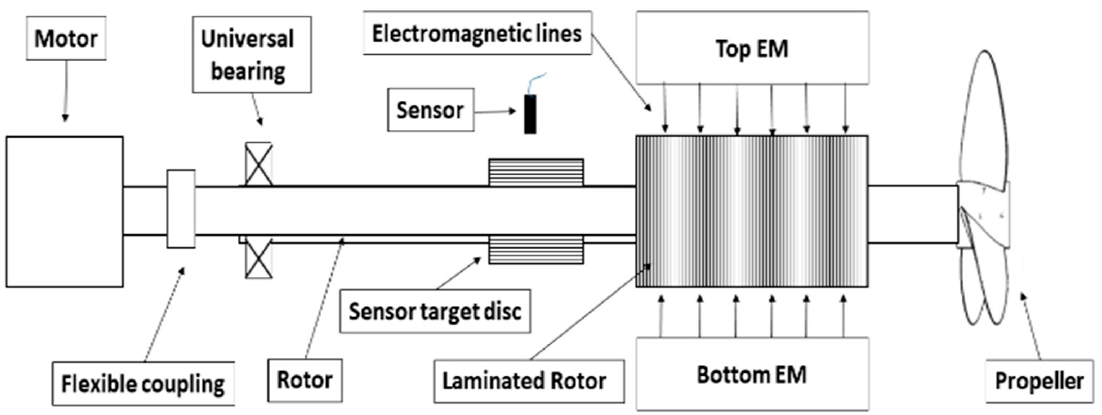
Figure 9. 2-DOF AMB experimental setup schematic.